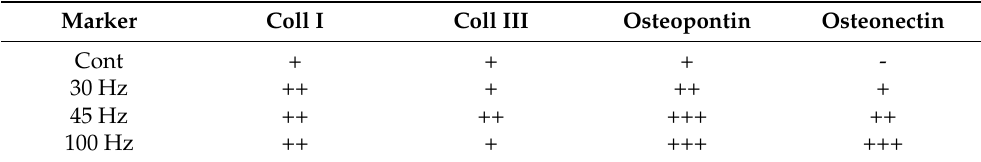
Table 1. Relative staining intensity score for coll I, coll III, osteopontin and osteonectin.